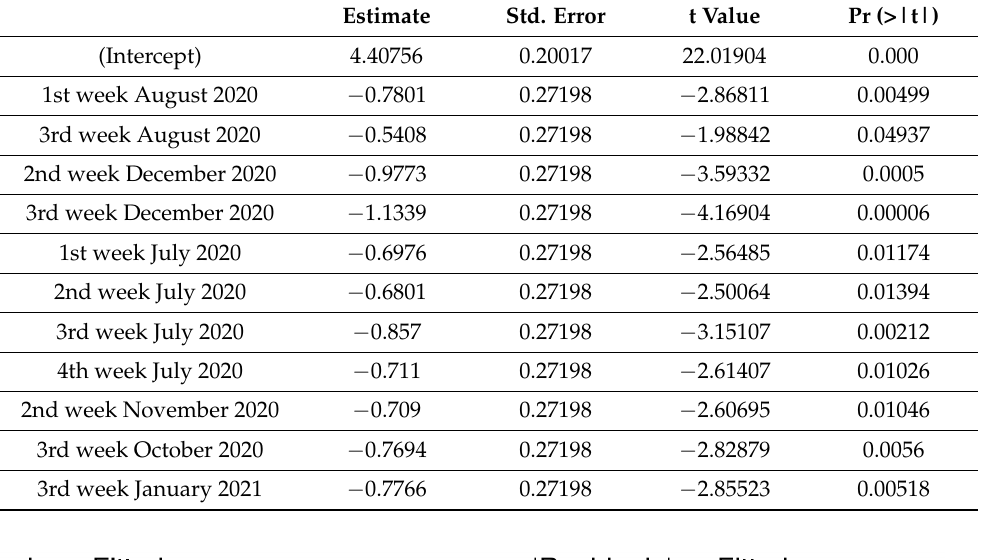
Table 5. Significant variable estimates for PM 10 .